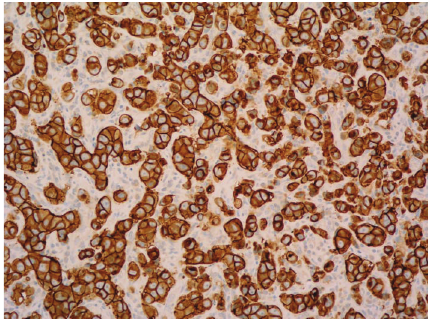
Figure 2: HER2 immunohistochemistry of cerebellar lesion— the vast majority of the neoplastic cells are positive with strong cytoplasmic membrane